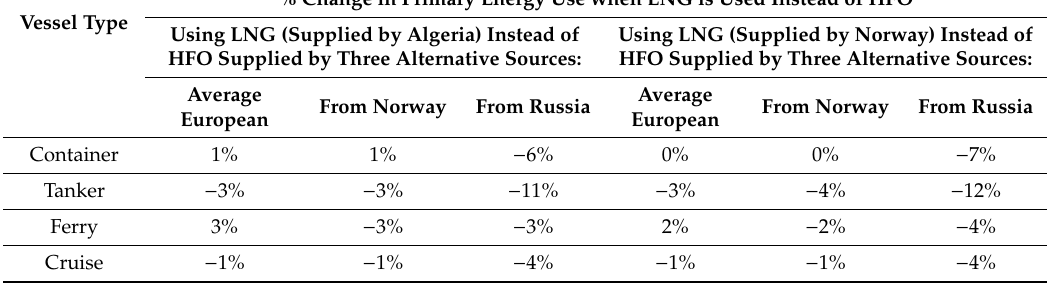
Table 6. Trends for Well-to-Propeller PEU for di ff erent case setups using di ff erent fuel supply chains of HFO normalized by the two LNG case setup outputs.